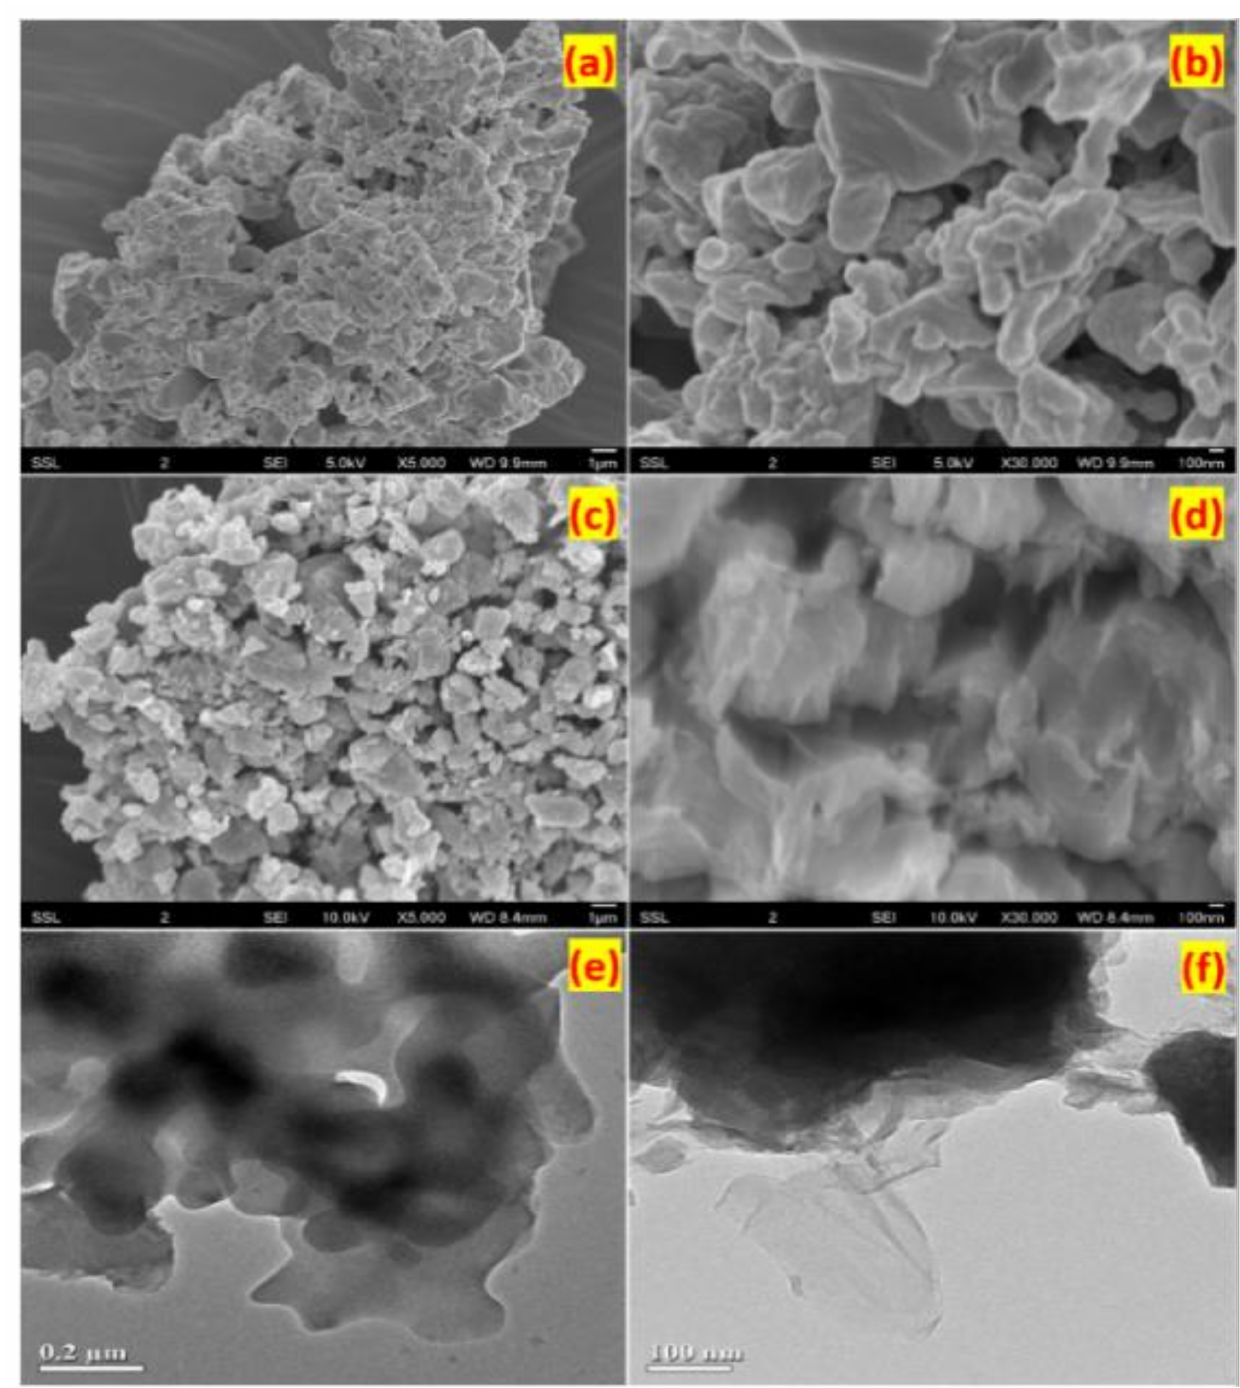
Figure 2. ( a , b ) SEM micrographs of NiFum at magnifications of 5000 and 30,000, respectively; ( c , d ) SEM micrographs of G-NiFum at magnifications of 5000 and 30,000, respectively; ( e , f ) TEM images of NiFum and G-NiFum,